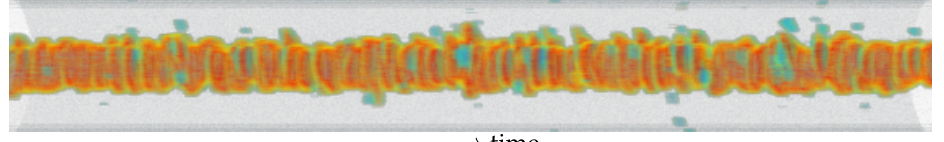
Figure 5. Gas core inside the inline swirl separator measured and reconstructed using classical ERT. A 2D sensor is used in the measurements, and the 3rd axis of the image (axial direction) corresponds to